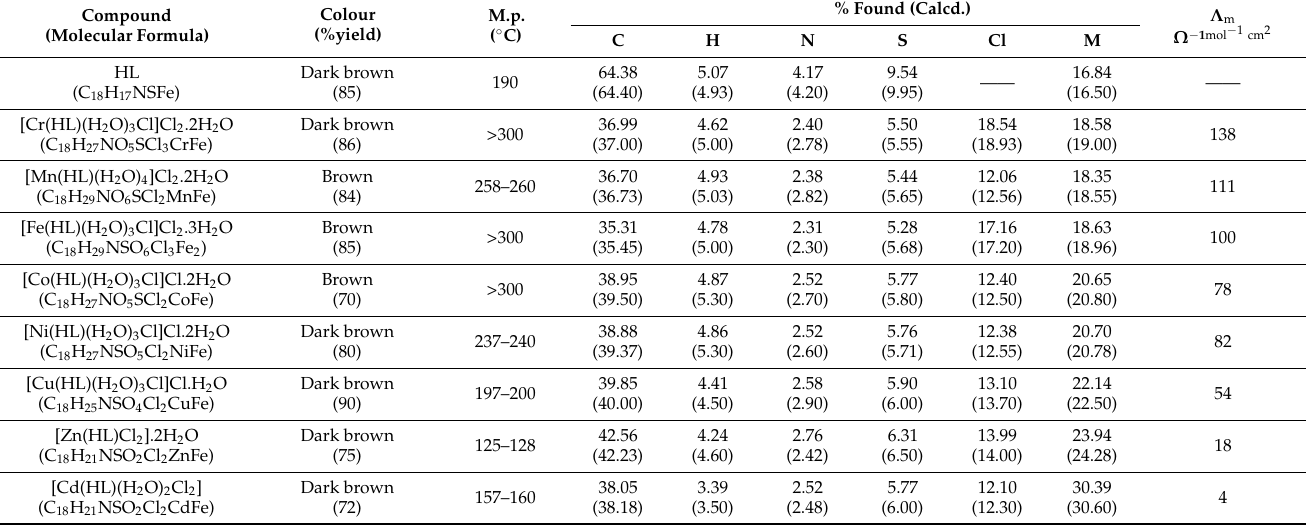
Table 1. Analytical and physical data of organometallic acetyl ferrocene imine ligand and its metal chelates.